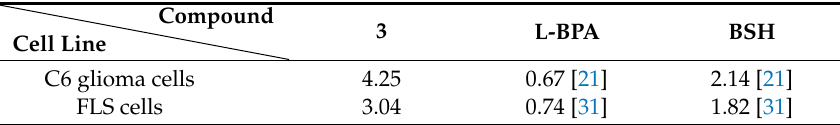
Table 2. Boron amounts delivered to the cells ( µ g / 10 7